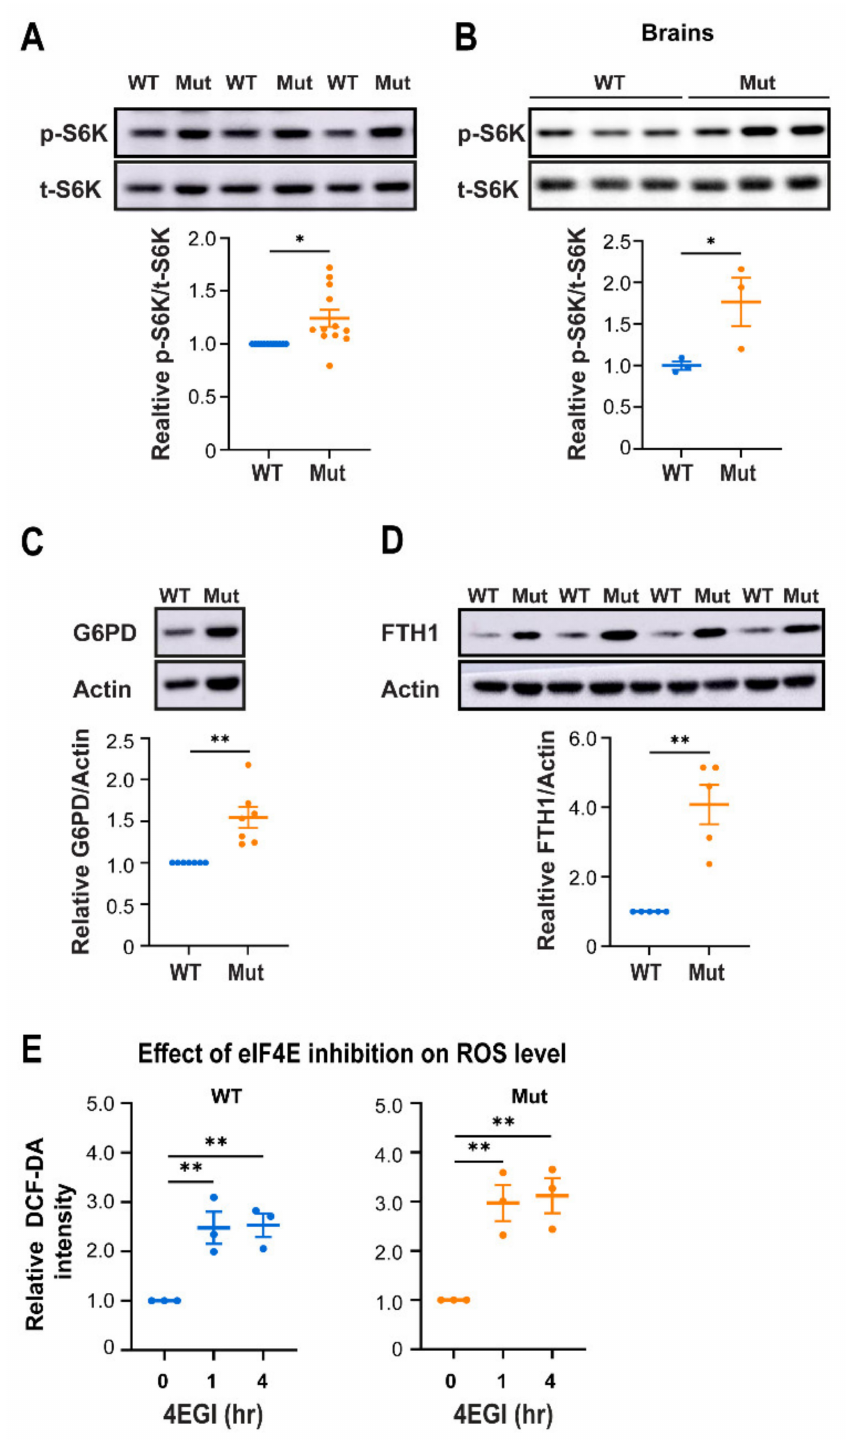
Figure 6. mTORC1 activity and its implications in WT (blue) and Mut (orange) primary astrocytes. ( A – D ) Equal amounts of total protein of primary astrocytes cultured in DMEM-HG, or brains at postnatal age of 10 months, were subjected to immunoblot analysis using antibodies specific for phospho-S6K (p-S6K) and total-S6K (t-S6K) ( A , B ), or G6PD and actin ( C ), or FTH1 and actin ( D ). Representative blots are shown. Data represent the average of the indicated ratios ± SEM normalized to WT. ( E ) Primary astrocytes grown in DMEM-HG were treated or not for 1 or 4 h with 400 µ M of 4EGI prior to analysis of ROS level by DCF-DA staining and flow cytometry. Data represent the average values of mean DCF-DA intensity ± SEM normalized to untreated cells. Statistical analysis is detailed in Materials and Methods. * p ≤ 0.05, ** p ≤